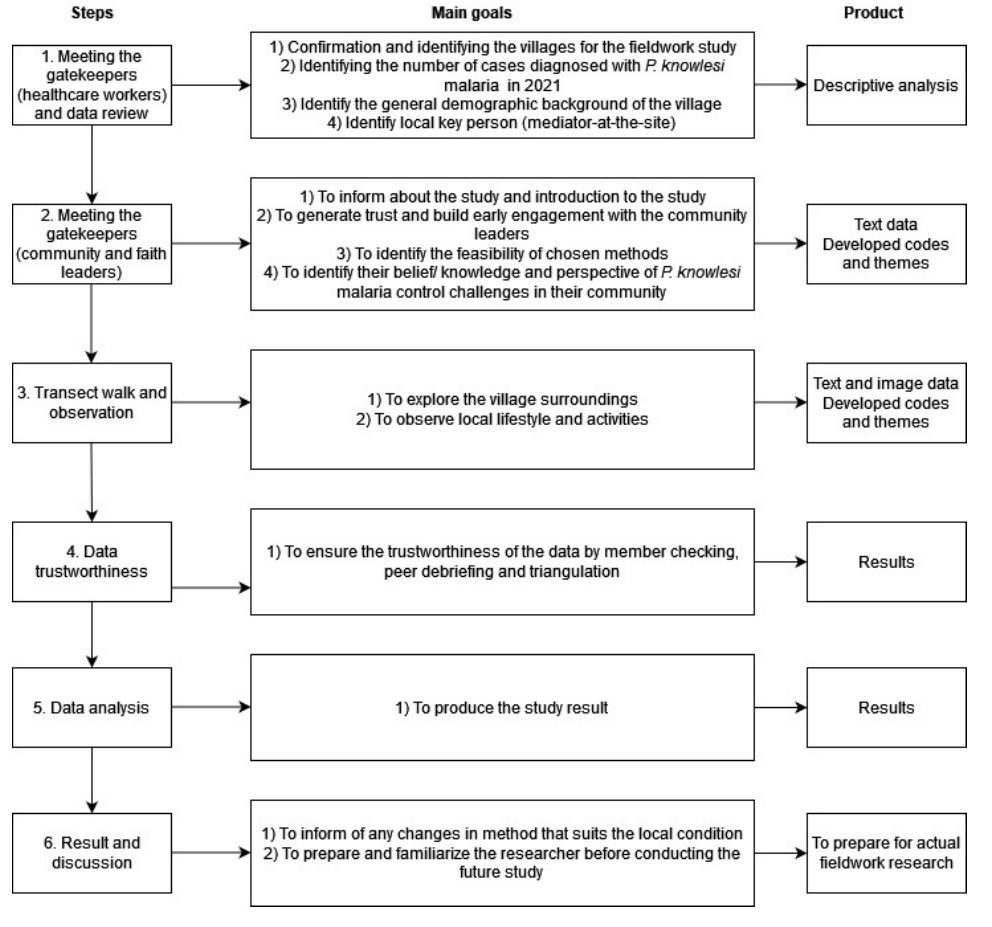
Figure 2. Flowchart of the systematic steps completed during the study, goals, and products.